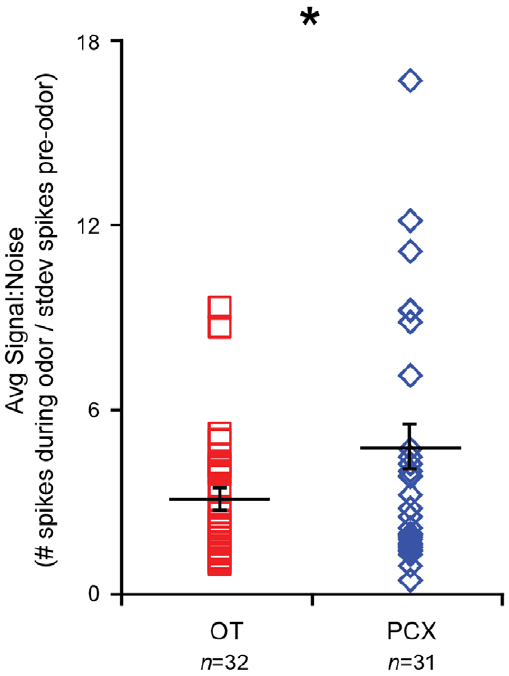
Figure 7. OT and PCX Odor signal:noise. ( A ) Average signal:noise (s:n, see Methods) in OT and PCX units. Each point represents average s:n of each unit, across all odor presentations ( . 4 trials/unit) and odors. Horizontal bars=average s:n across units 6 SEM. * p , 0.05, ANOVA followed by Fisher’s PLSD.